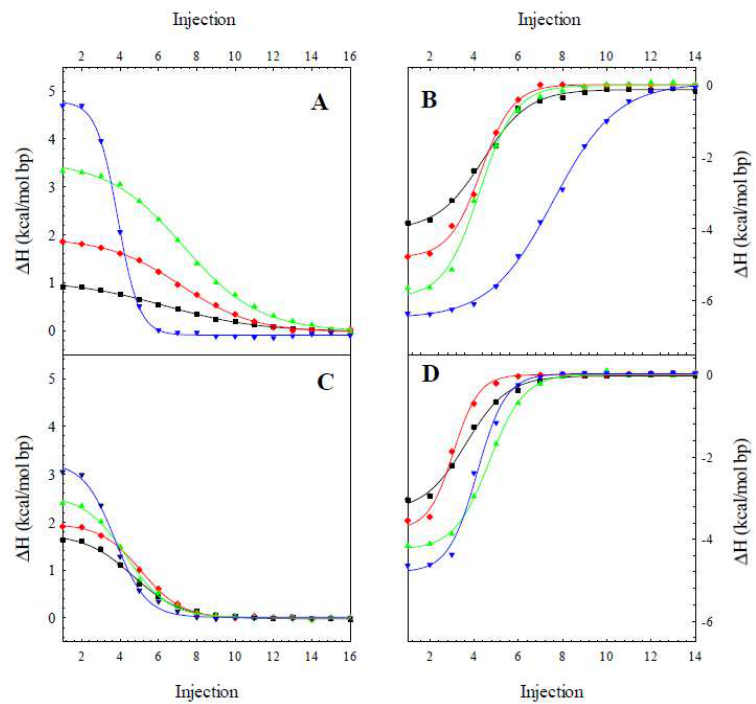
Figure 1. ITC Binding isotherms obtained for ( A ) Z8A and NaCl; ( B ) Z8A and [Co(NH 3 ) 6 ] 3+ ; ( C ) Z8M and NaCl; and ( D ) Z8M and [Co(NH 3 ) 6 ] 3+ interactions as a function of temperature: 25 °C (black), 35 °C (red), 45 °C (green), and 55 °C (blue). The integrated results of the data after subtraction of the heats of dilution are represented and the solid lines are the best least-square fits of the integrated data. Our transition enthalpy of 0.71 kcal/mol bp obtained at 25 °C using Na + compares quite favorably Table 1. Summary of ITC determined enthalpies for the titrations of Z8A and